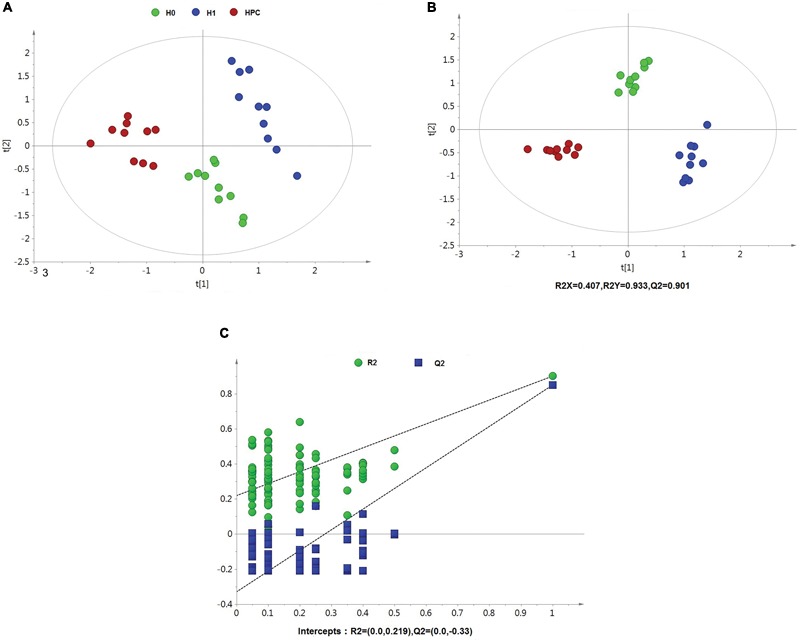
Multivariate data analysis based on hippocampus spectral data of UHPLC-QTOFMS positive ion mode. (A) PCA score map derived from UHPLC-QTOFMS spectra concerning H0, H1, and HPC groups. (B) PLS-DA score map derived from UHPLC-QTOFMS spectra concerning H0, H1, and HPC groups. (C) Validation plot obtained from 99 permutation tests.